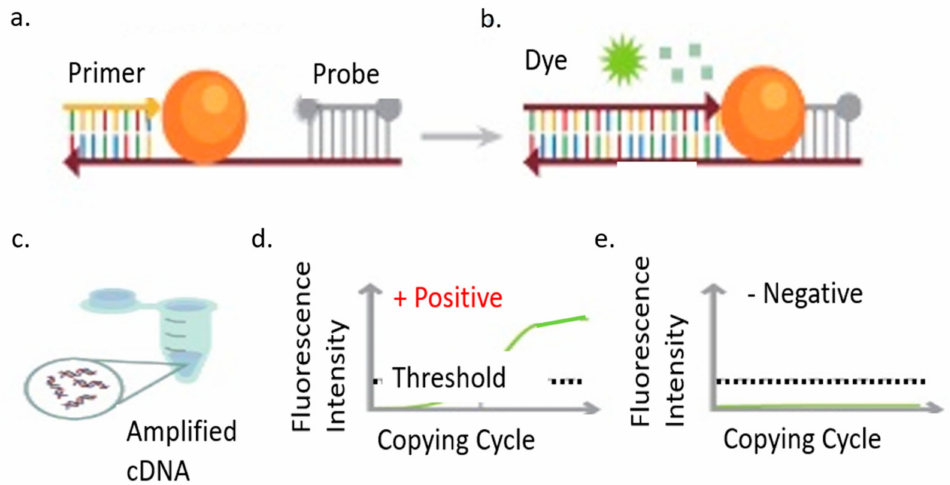
Figure 6. COVID-19 nucleic acid amplification RT-PCR test, ( a ). Primer application, ( b ). Fluorescent dye used for visual amplification, ( c ). Complimentary DNA amplified through RT-PCR process, ( d ). Positive case threshold surpassed, ( e ). Negative case threshold not